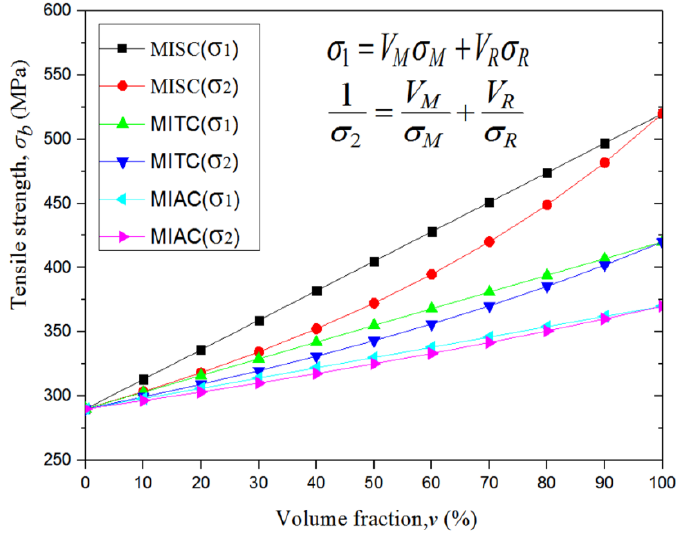
Figure 11. The relationship between tensile strength and volume fraction of magnesium matrix composites interpenetrated by different reinforcement.